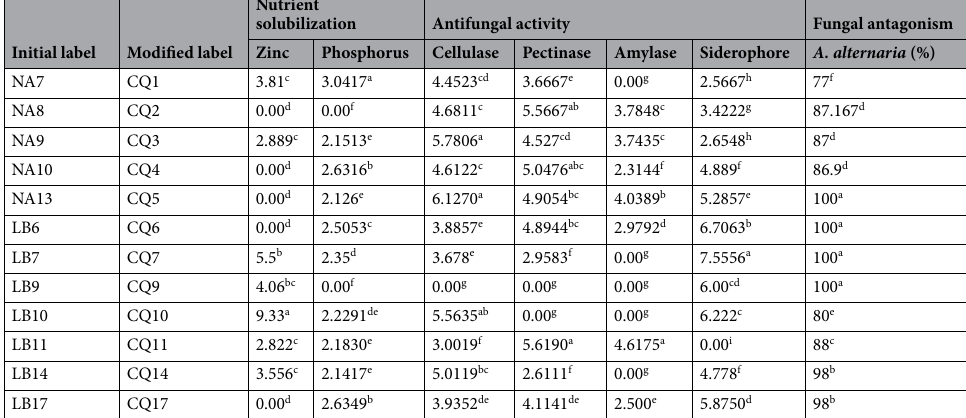
Table 1. Screening of rhizobacteria associated with Chenopodium quinoa. All values are means of three replicates. Values with different letters in the same column are significantly different at p ≤